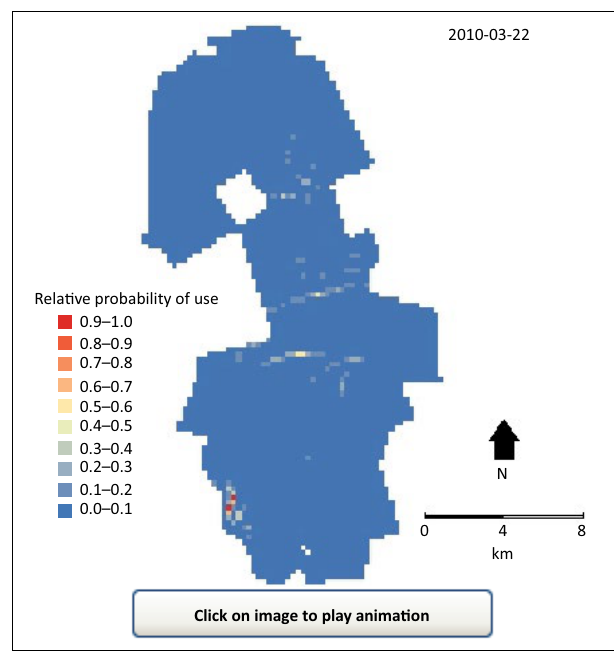
FIGURE 1-A4: Animation of predicted space use by female elephants in the morning (06:00) in Addo Elephant National Park, South Africa. Predicted use reflects step selection function model predictions to the elephant-accessible Main Camp – Colchester section of Addo Elephant National Park for 16-day periods from 06 March 2010 to 21 March 2013, corresponding to the Moderate Resolution Imaging Spectroradiometer composites used for analysis (see the main text for details).